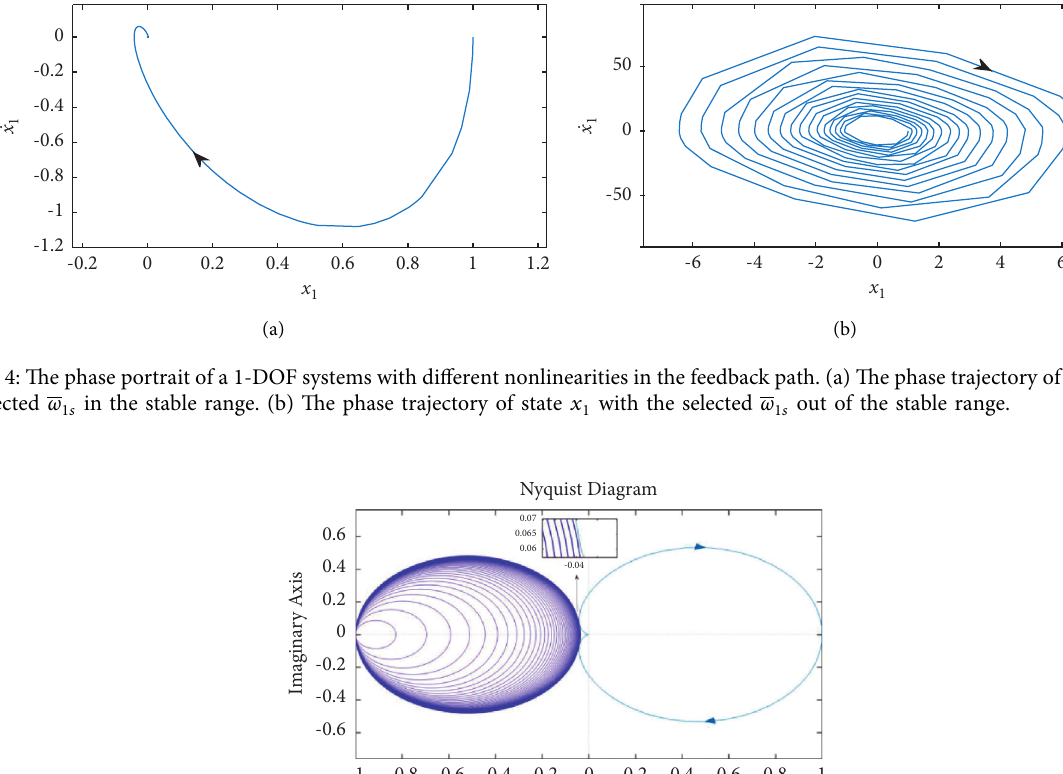
Figure 5: The Nyquist diagram with ω